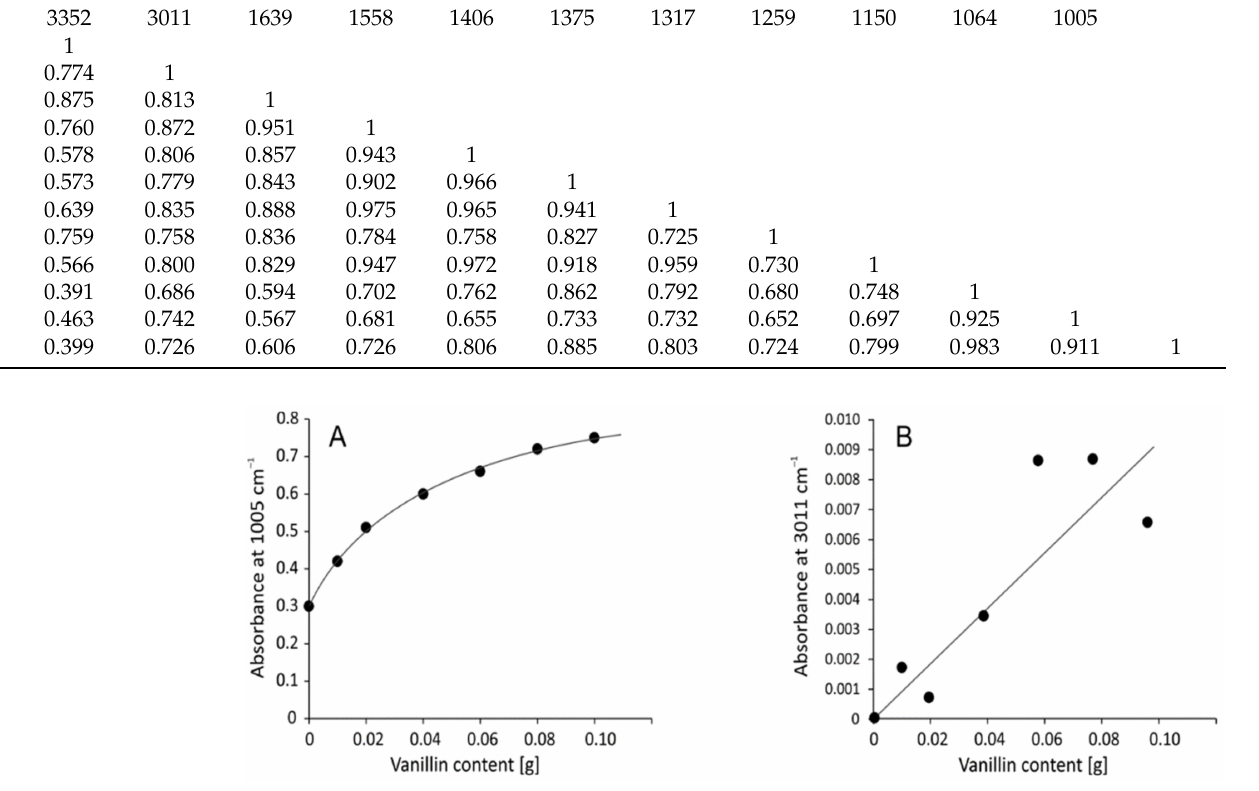
Figure 2. The intensity of the band at 1005 cm − 1 ( A ) and 3011 cm − 1 ( B ) vs. vanillin content in